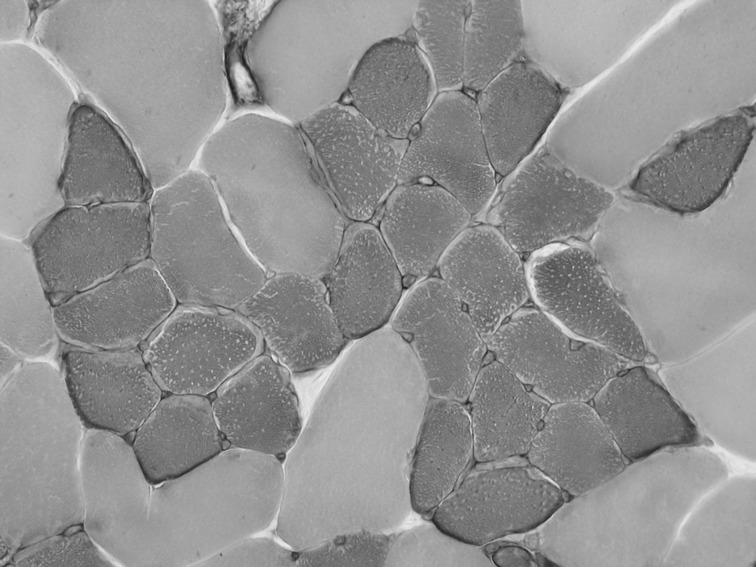
Exemplarily fiber type grouping in one rat as a histologic parameter of reinnervation (81 days after phrenicotomy in the mid-costal area).